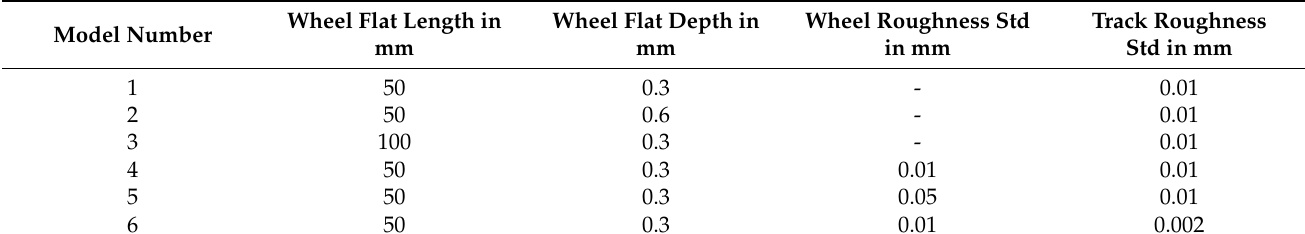
Table 1. Parameters of the different relative displacement models.